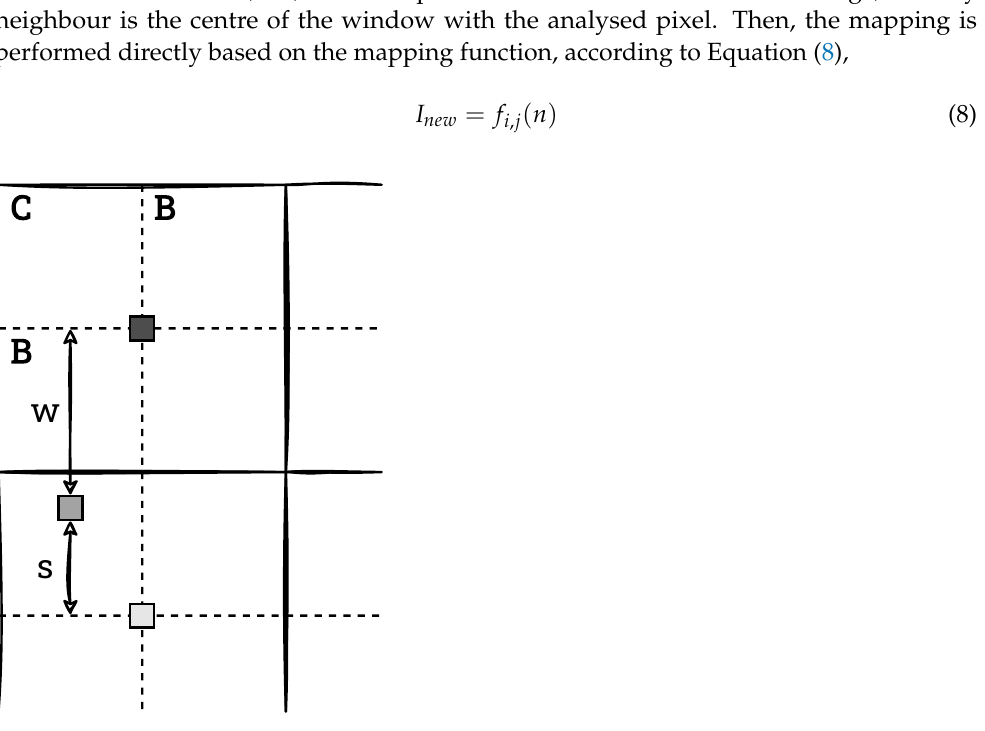
Figure 8. Linear interpolation scheme (for pixels on the image edge). C stands for corner region and B for border